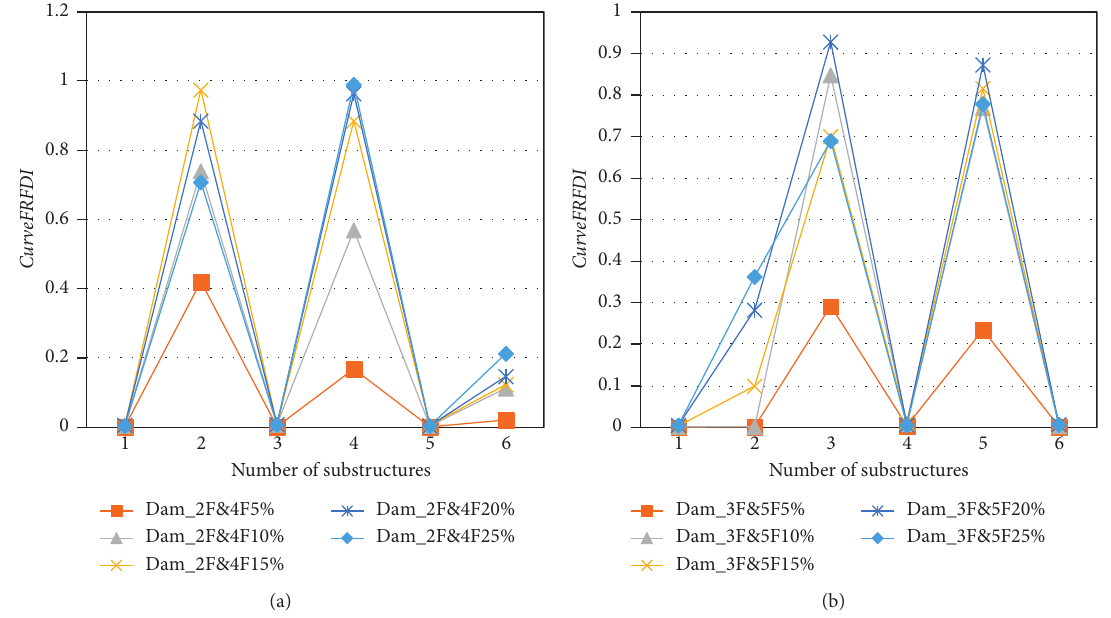
Figure 20: The comparison of the CurveFRFDI for 5%, 10%, 15%, 20%, and 25% stiffness reduction in (a) the 2 nd and the 4 th floors and (b) the 3 rd and the 5 th